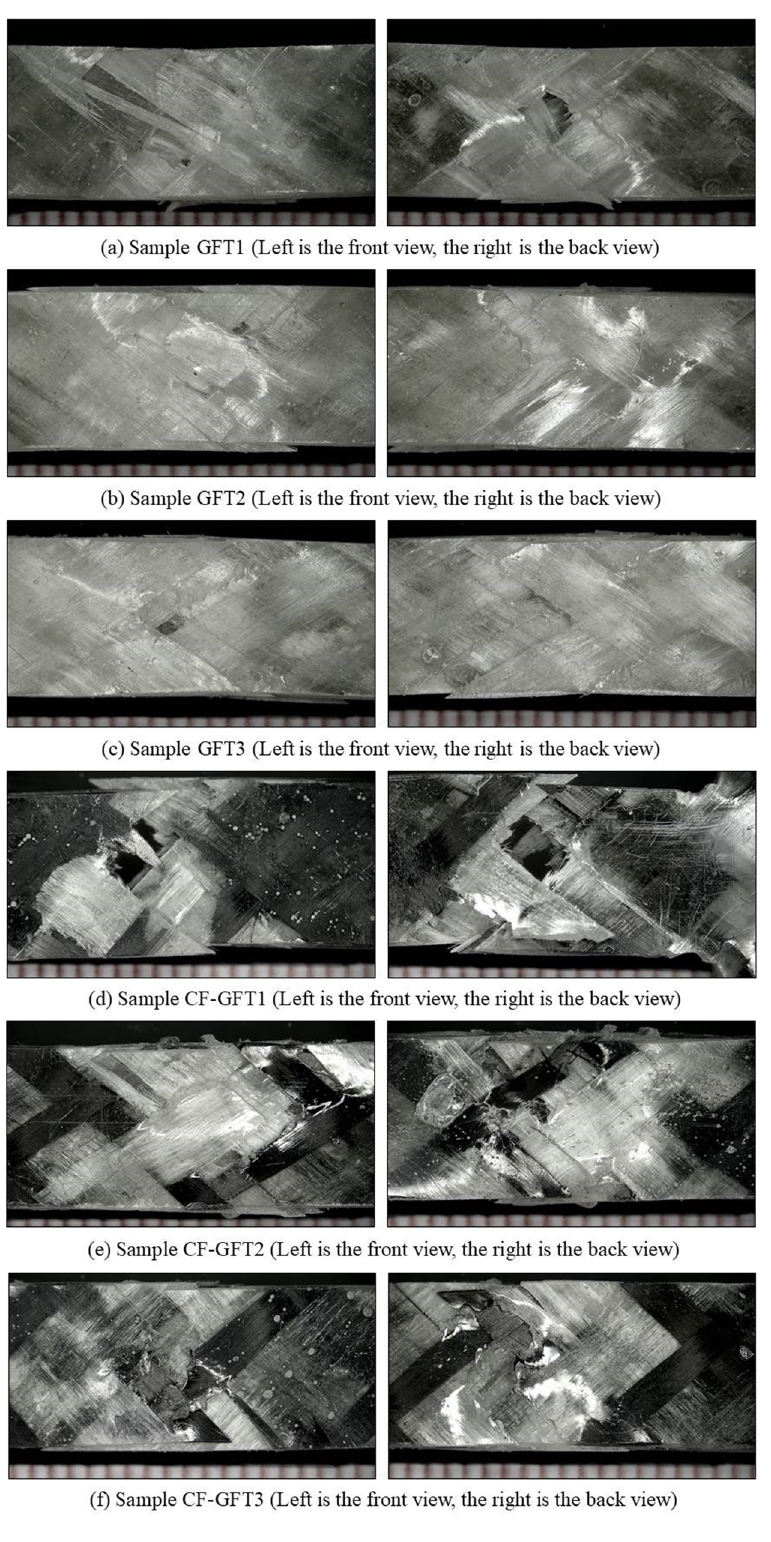
Figure 9: Tensile fracture morphology of 2D braided composites at di ff erent temperatures: ( a ) 25°C, ( b ) 45°C, ( c ) 60°C, ( d ) 25°C, ( e ) 45°C, and ( f )